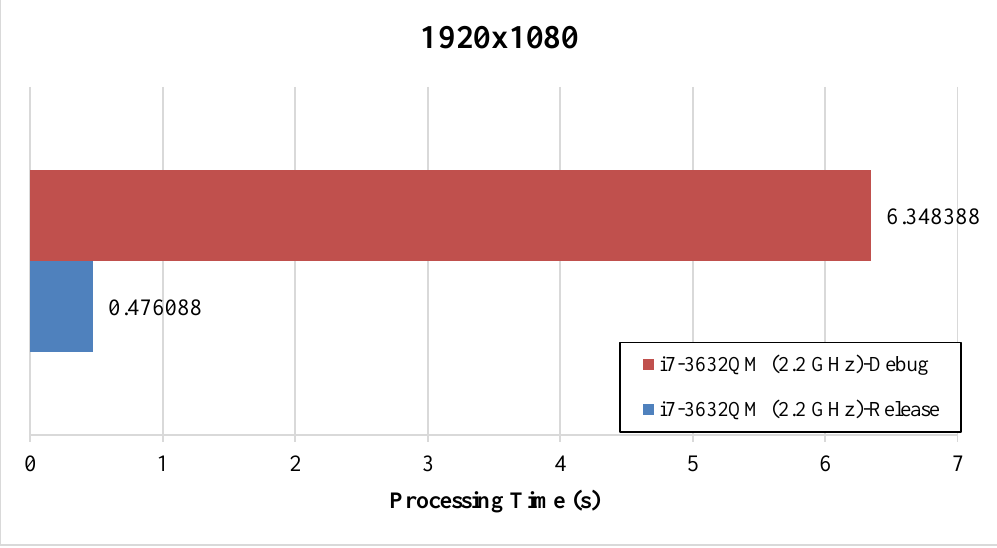
Figure 7. Compare the best runtime CPU in Debug and Release